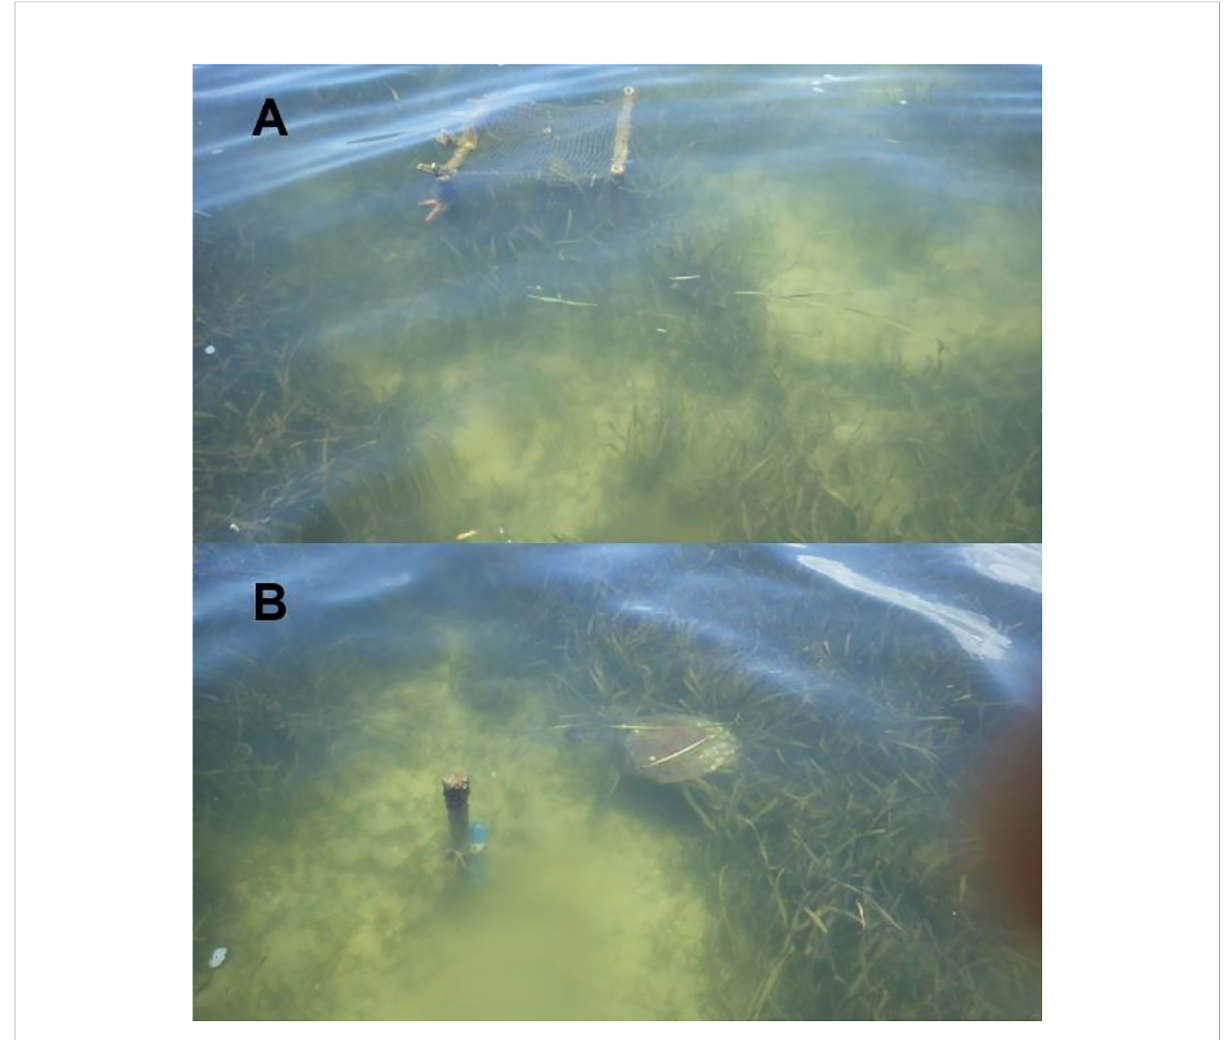
FIGURE 10 (A) green turtle ( Chelonia mydas ) grazed area adjacent to one of the cages; and (B) a juvenile green turtle entering a grazed patch near a temperature sensor just outside our experimental cage